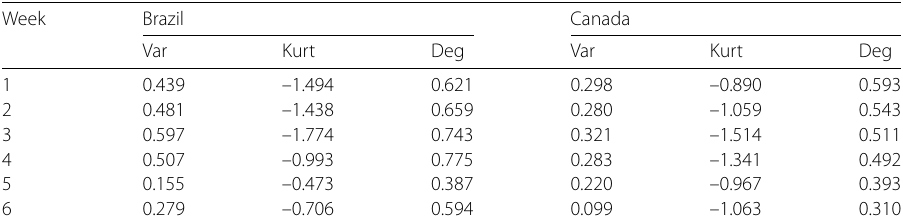
Table 1 Polarization analysis. P ( H ) summarized variables: variance (var), kurtosis (kurt) and polarization degree (deg)